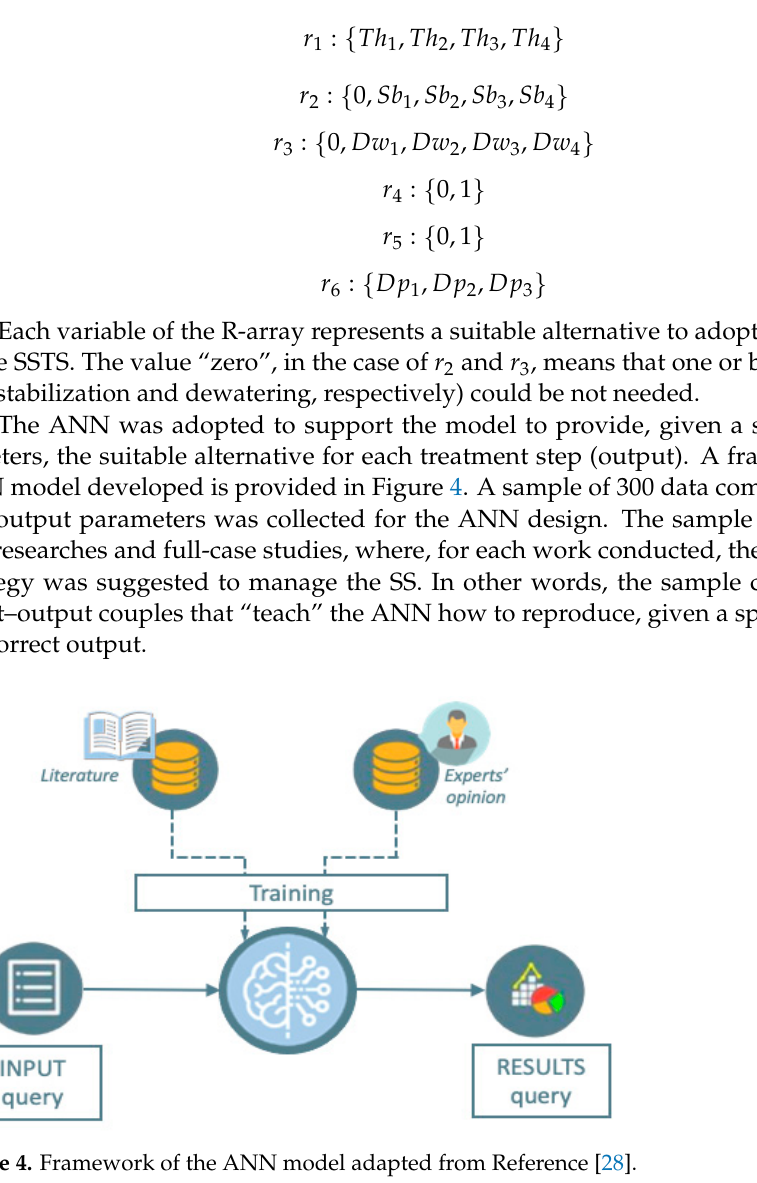
Figure 4. Framework of the ANN model adapted from Reference [28].